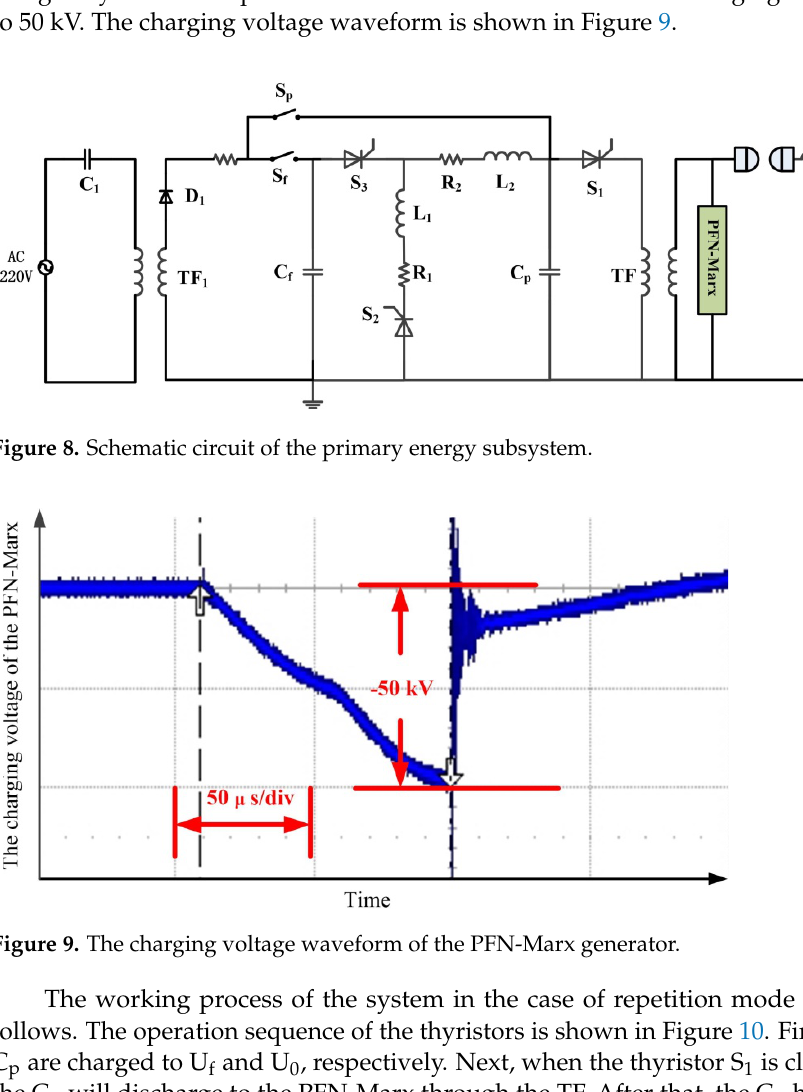
Figure 7. Assembly diagram of the PFN-Marx (a—support rod, b—gas switch, c—PFN module).